Question: Summarize what this figure shows in one sentence.
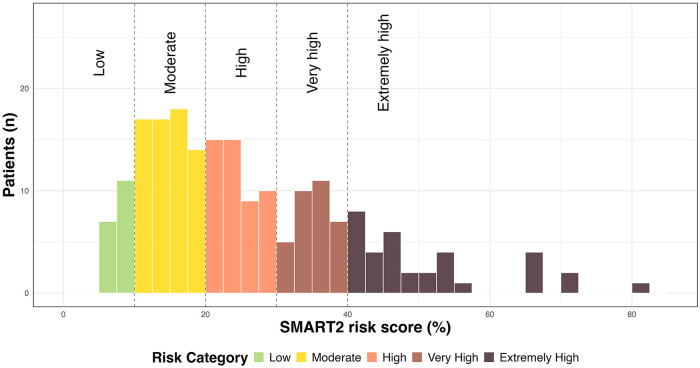
Answer: Distribution and risk categorisation of SMART2 scores at baseline. n , number; SMART2, Second Manifestations of ARTerial disease, version 2.